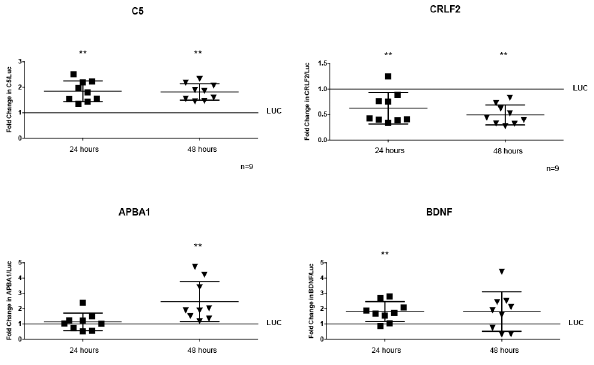
Fig 4. Quantitative RT-qPCR demonstrate that Tat complex modulates expression of C5, CRLF2, APBA1, and BDNF. THP-1-Tat-Flag and THP-1-luciferase cell lines generatedfrom 5–6 independents sets of infectionand selectionwere differentiated to macrophages with PMA for 24 and 48 hours. Total RNA was extracted, and cDNA was generatedand a RT-qPCR performed. Quantificationis expressedin arbitrary units, relativeto THP-1-luciferase set to 1, and target mRNA levels were normalizedto 18S expressionusing the method of Pfaffl. Tat complex increasedthe expressionof C5 at 24 and 48 hours, decreasedthe expression of CRLF2 at 24 and 48 hours, increasedthe expressionof APBA1 at 48 hours and increasedthe expression of BDNF after 24 hours of PMA treatment. Significancewas determined using a Wilcoxon signed-ranktest. Error bars represent the median ± S.D.; ** P <